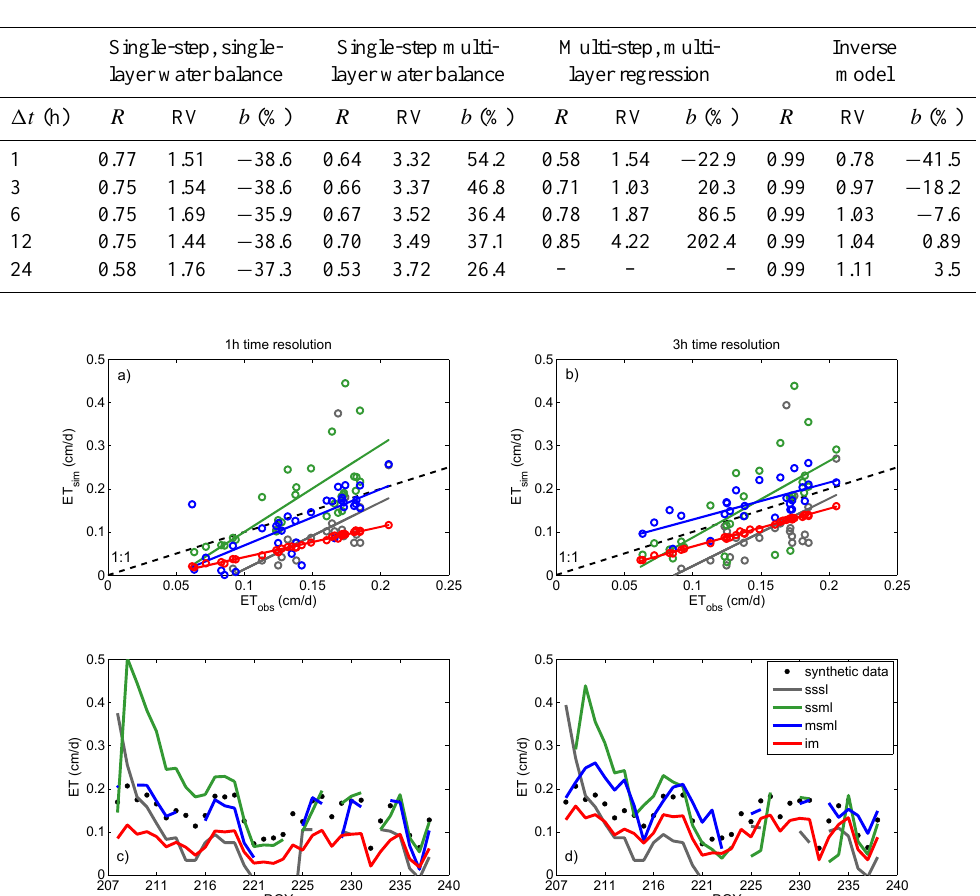
Table 2. Comparison of the model performance of the four data-driven methods for reproducing daily evapotranspiration for the particular time resolution of soil moisture measurements. The model performance is expressed as correlation coefficient R , relative variability in simulated and reference values (RV), and relative bias ( b ) for the period 25 July–26 August 2009. Days on which rainfall occurs were excluded for the data analysis.